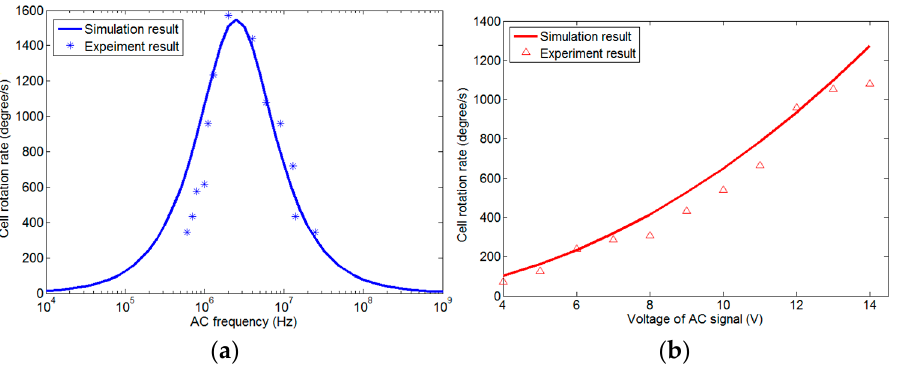
Figure 10. Comparison between simulated and experimental rotation rates of HeLa cells. ( a ) The relationship between the cell rotation rate and the AC frequency at V p-p = 7 V. ( b ) The relationship between the cell rotation rate and the voltage at f = 600 kHz.